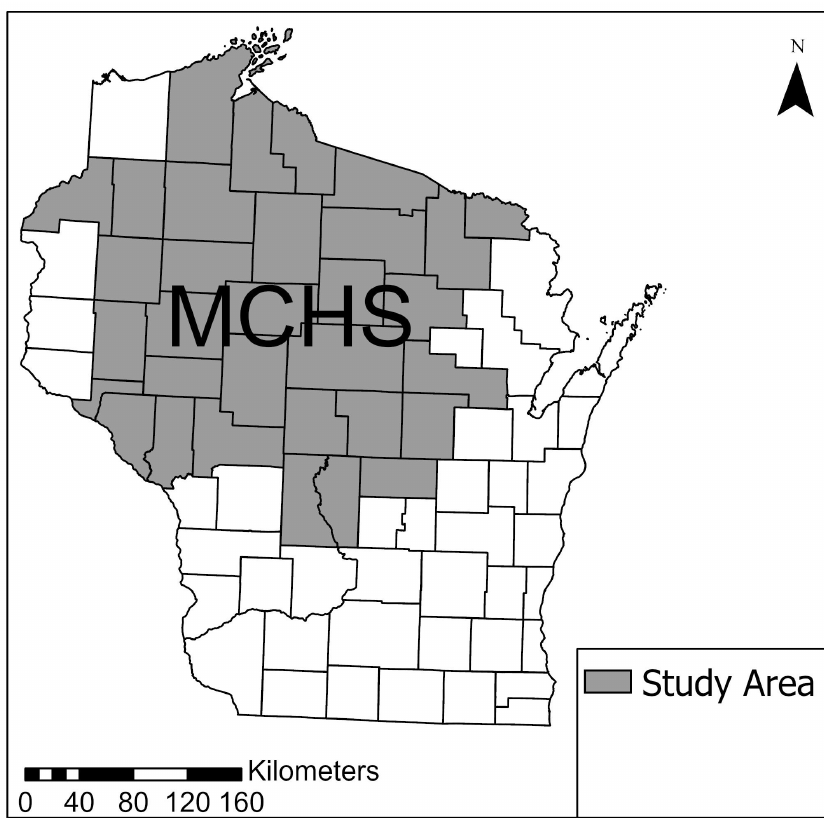
Figure 1. The Marshfield Clinic Health System (MCHS) study area located in the central and northwestern portion of Wisconsin (denoted in gray)